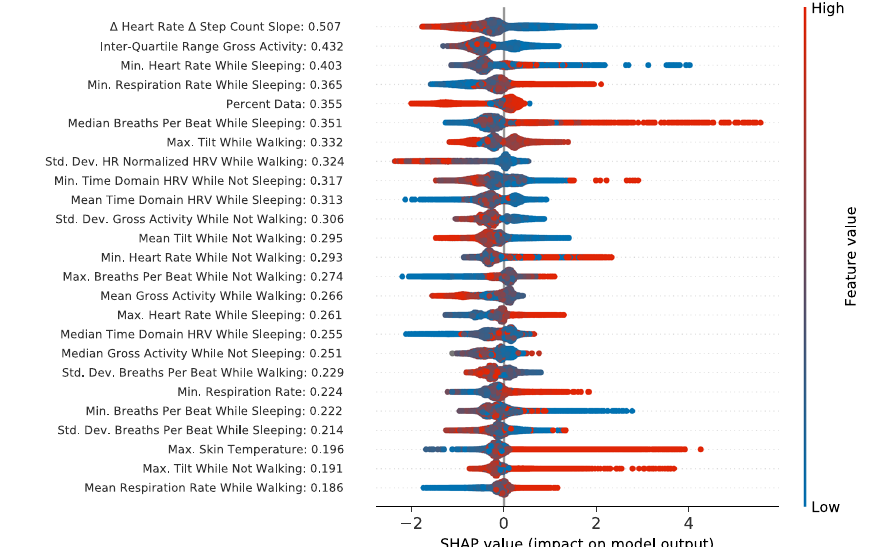
Fig. 2 Shapley additive explanations (SHAP) scores of the most important 25 features, plotted as a beeswarm plot. Each point represents one datapoint in the training set, colored based on the relative value of the feature, where red is a high feature value, and blue is a low feature value. Points contributing to a positive (for hospitalization) decision have positive values, while those contributing to a negative (no hospitalization) decision have negative values. The mean absolute value of the SHAP scores is listed next to each feature name.